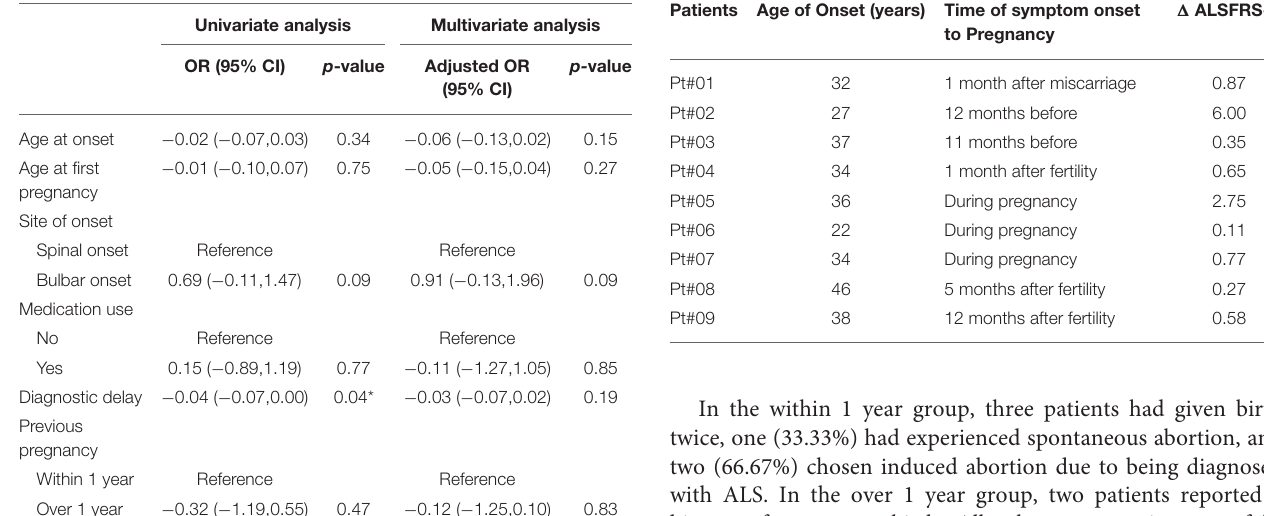
TABLE 5 | The temporal relationship and disease progression in patients in the within 1 year